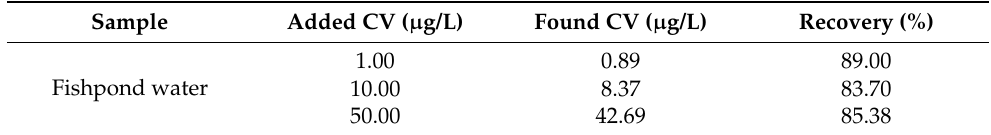
Table 2. The recovery of CV in spiked fishpond